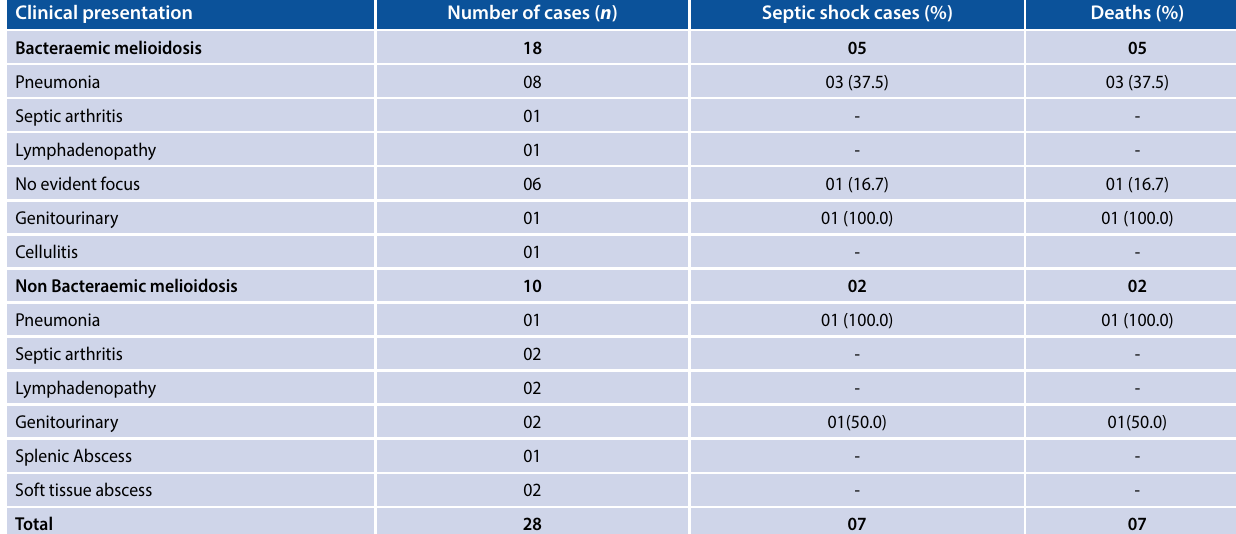
Table 1: Clinical presentation in melioidosis cases Clinical